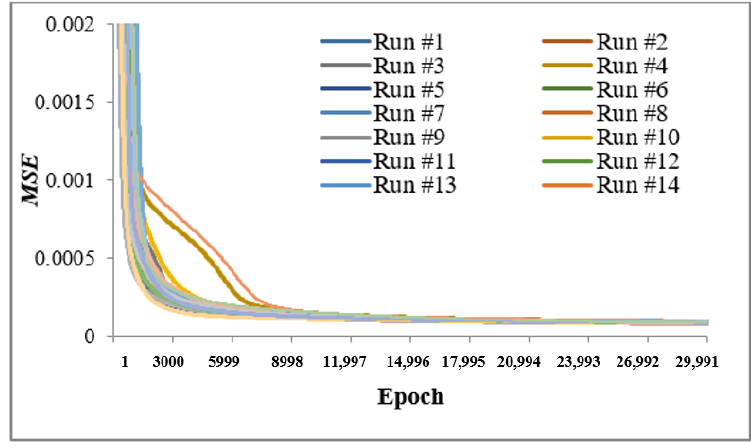
Figure 4. Learning curve: Experiment 9.